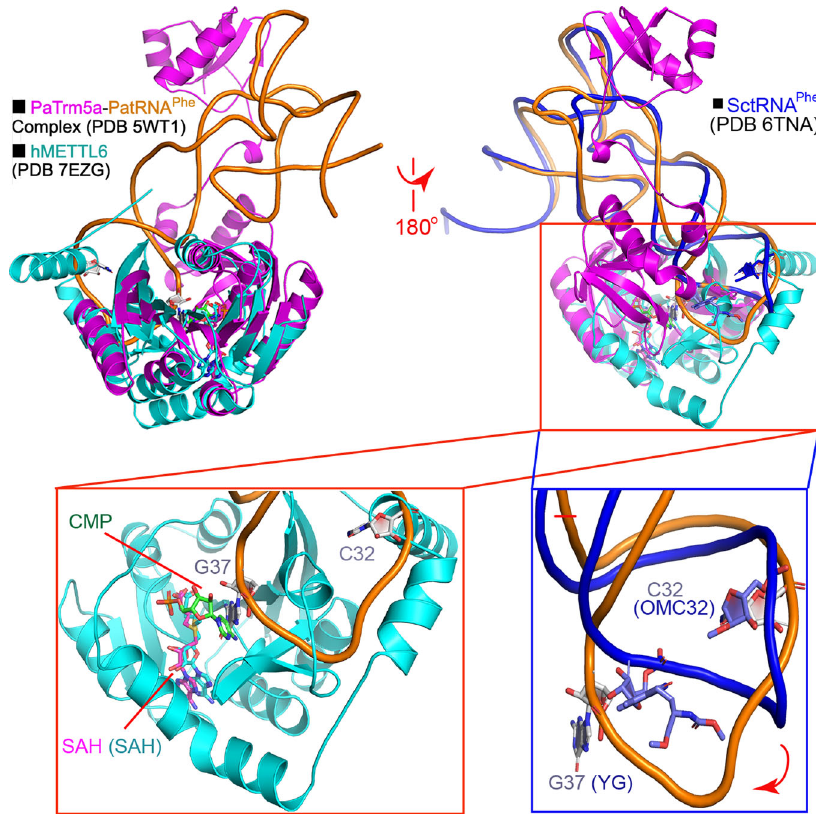
Fig. 6 The binary model of the hMETTL6-tRNA complex. Top panel: the superimposition of hMETTL6 with that of the PaTrm5a-PatRNA Phe -SAH complex in the front and back views (PDB 5WT1). The blue molecule on the top right corner represents the yeast tRNA Phe molecule (SctRNA Phe ) with a classical conformation (PDB 6TNA). Bottom panel: the close views of the anticodon loop interactions with the hMETTL6-SAH complex (left) and the comparison of these regions from two tRNA molecules (right). The red arrow indicated the rotation of the anticodon loop needed for the methylation. The bases at positions of 32 and 37 were shown. Note that the bases of SctRNA Phe were modi fi ed. OMC: 2 ′ -O methylcytosine; YG: wybutosine. The coloring of the molecules corresponded to their